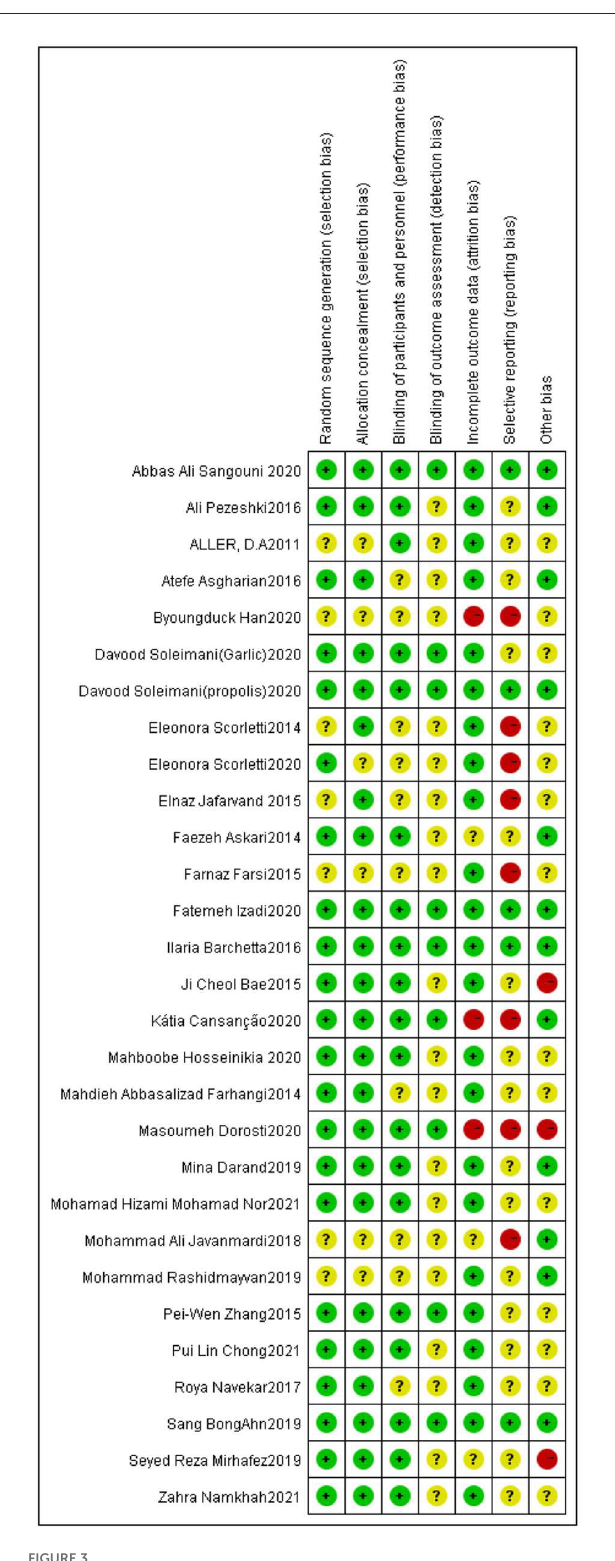
FIGURE3 Risk of bias summary: review authors’ judgements about each risk of bias item for each included study.